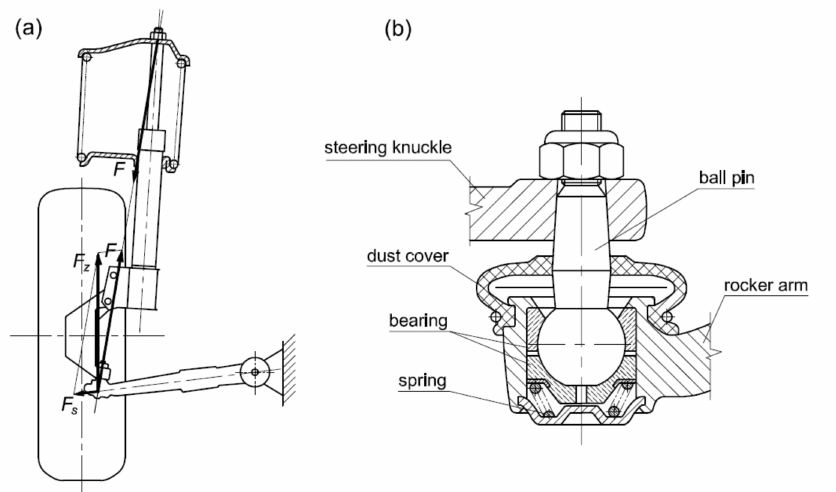
Figure 2. Forces acting on the rocker arm pin ( a ), rocker arm pin ( b ): F —force acting on the bodywork, F s —side force, F z —vertical force.